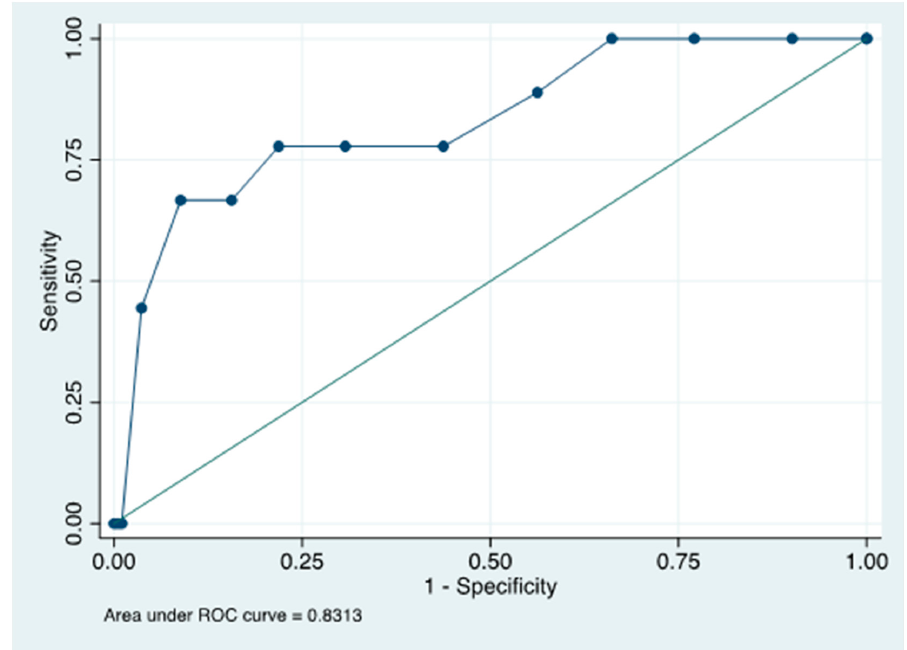
Figure 2. ROC curve for the prediction of mortality. Abbreviations: ROC, receiver operator charac- teristic.